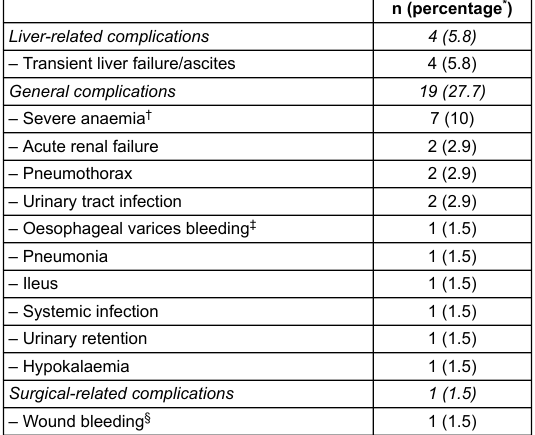
Table 5: Reported complications after laparoscopic liver